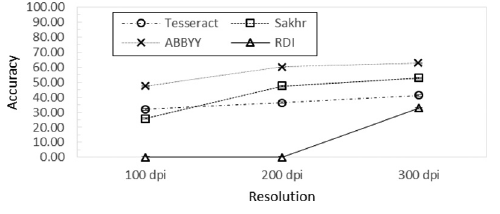
Figure 4. Character accuracy in